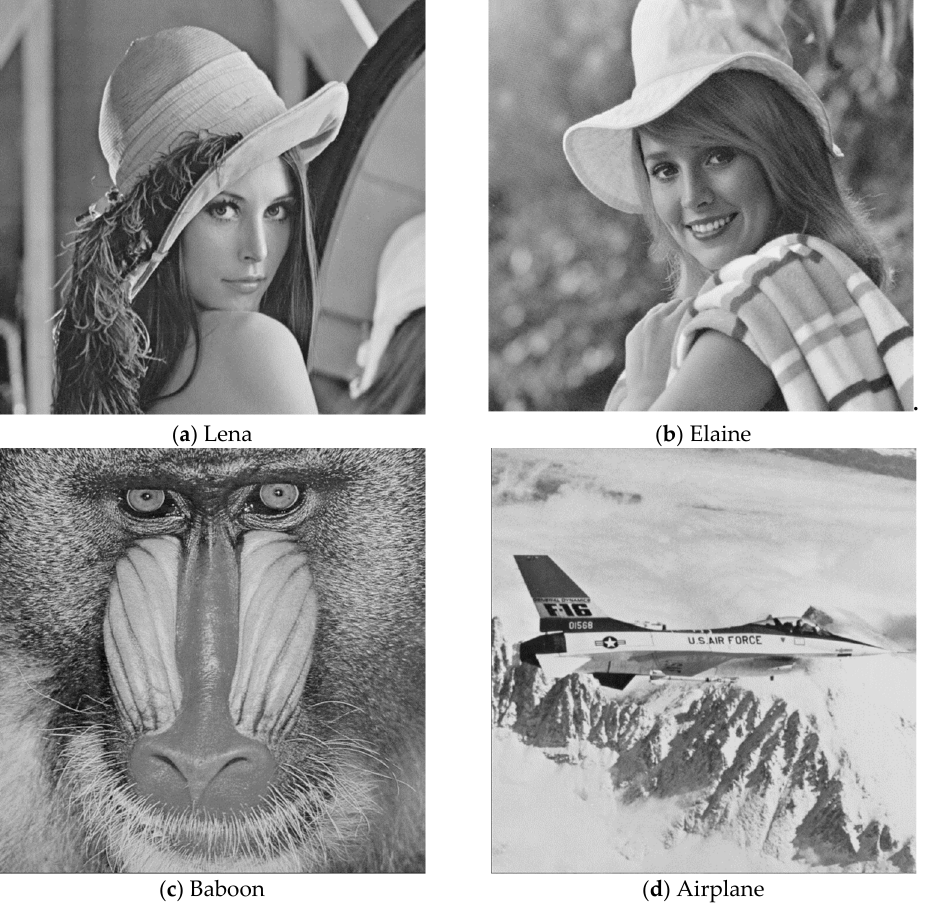
Figure 10. Four original grey-scale images: ( a ) Lena, ( b ) Elaine, ( c ) Baboon, and ( d ) Airplane.